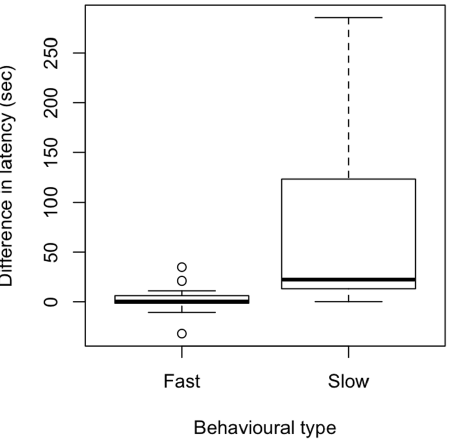
Figure 2. The median difference in the latency to attack prey for the novel person (day 8) minus latency for the last day familiar person (day 7) for fast and slow birds. Positive values indicate that birds took longer to attack prey when the novel observer was timing the birds compared with a familiar observer. The box indicates the first and third quartiles whilst the bars indicate the 10 th and 90 th percentiles.